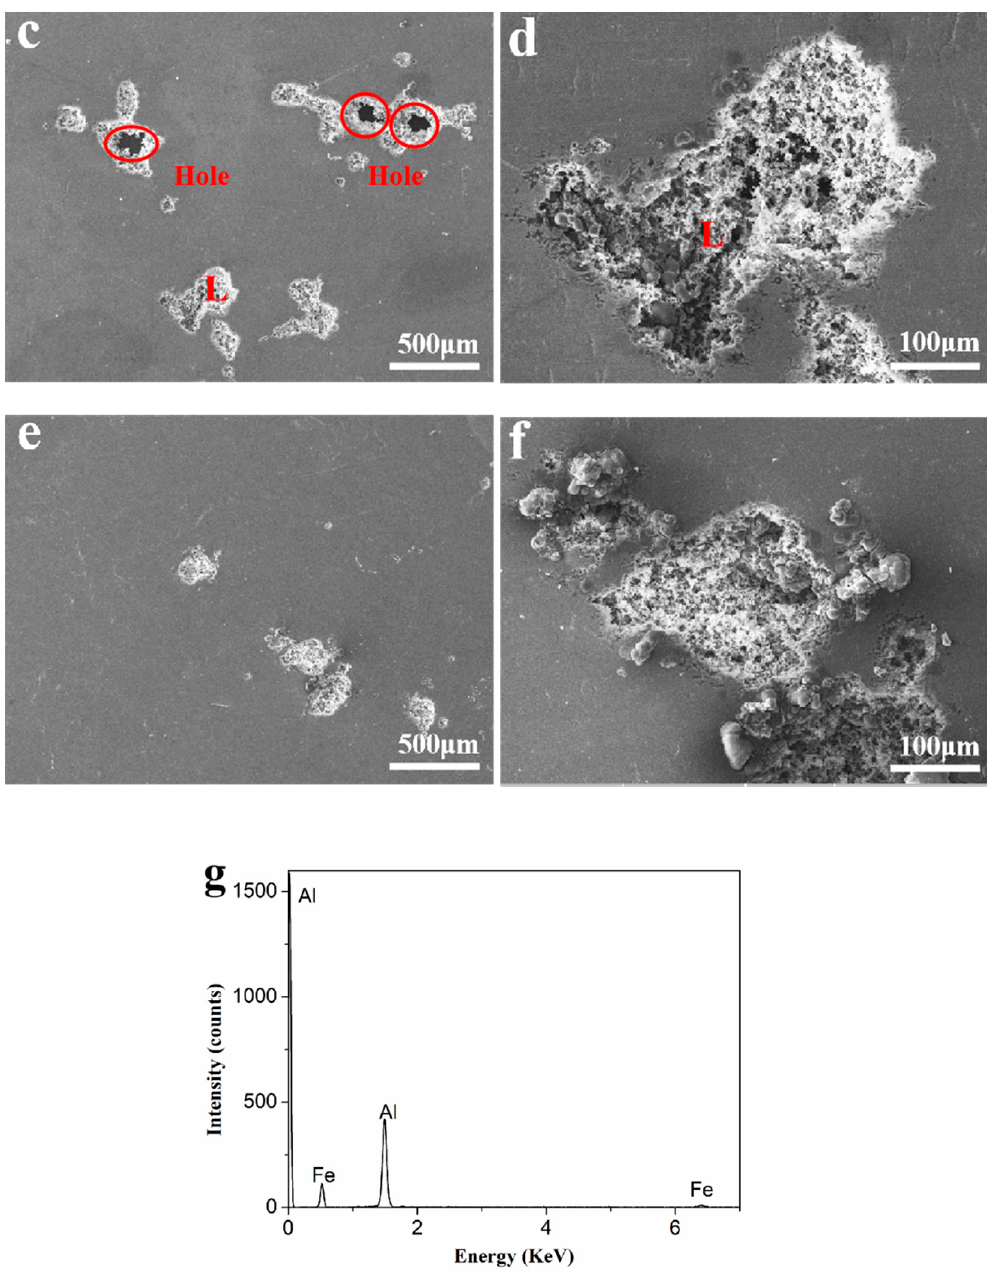
Figure 5. Corrosion surface morphology of the Al-xFe-0.07La alloy foils in 3.5% NaCl solution: ( a ) and ( b ) Al-0.07Fe-0.07La; ( c ) and ( d ) Al-0.1Fe-0.07La; ( e ) and ( f ) Al-0.2Fe-0.07La; ( g ) EDS analysis of corrosion pit L.